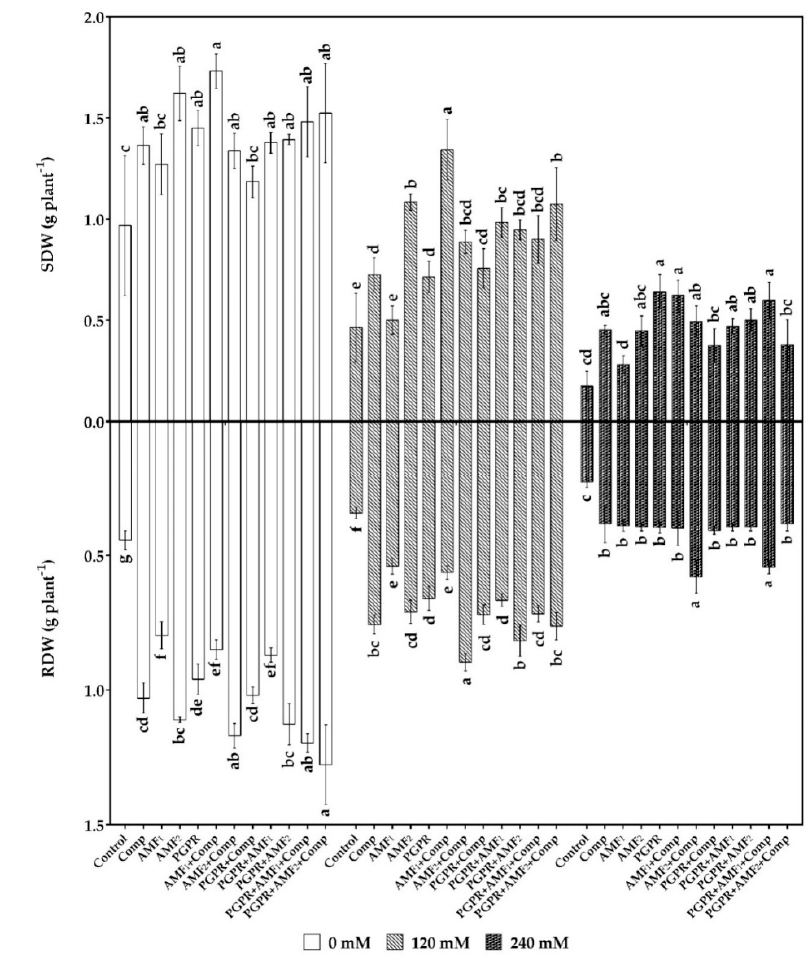
Figure 2. Effects of salt stress and biofertilizers on shoot dry weight (SDW) and root dry